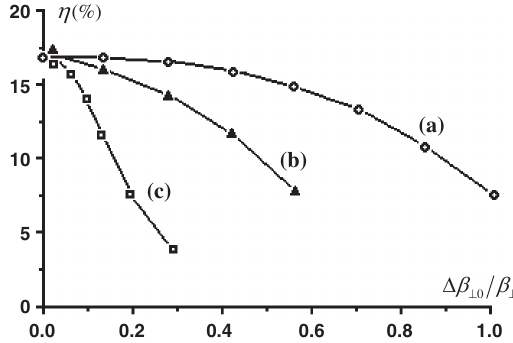
FIG. 8. Influence of initial velocity spread. The electron effi- ciency averaged over all the beam fractions versus the initial parasitic transverse velocity presented in the beam: (a) FEL with reversed guide field for parameters given in Fig. 6; (b) FEL with conventional guide field for parameters given in Fig. 10; (c) CARM of the same frequency, electron energy, and pitch